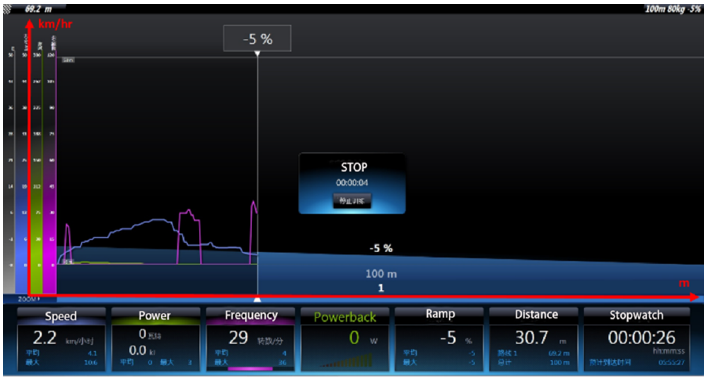
Figure 20. Results for flat road, cyclist weight 80 kg, and electromagnetic reversal braking. Actuators 2020 , 9 , x FOR PEER REVIEW